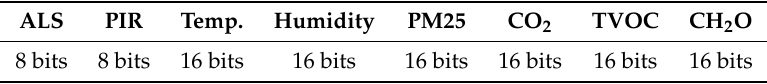
Table 10. Message body structure for sensor reporting command.